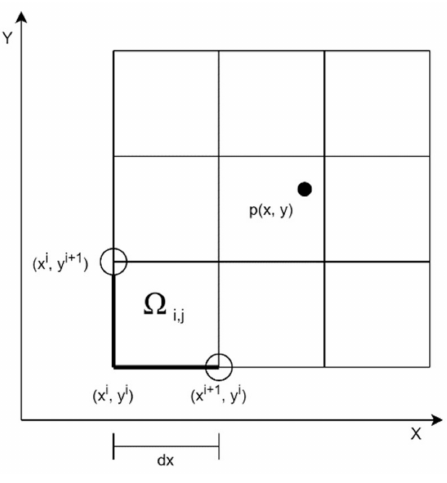
Figure 1. Dividing the area into